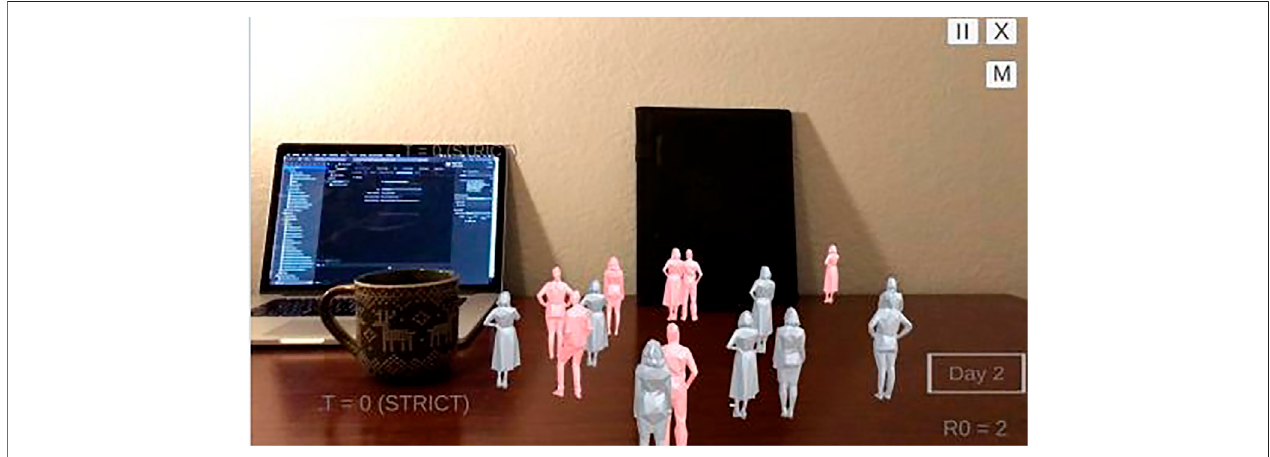
FIGURE 1 | The fi rst augmented reality (AR) version of the CovidCampus game with interactive time and R-naught controls.